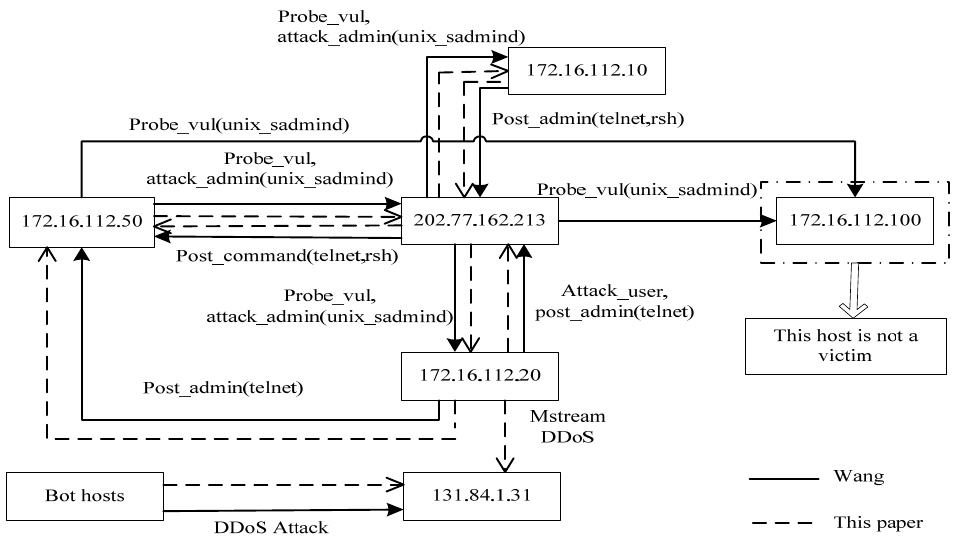
Figure 11. Comparison between VERA and Wang’s method.